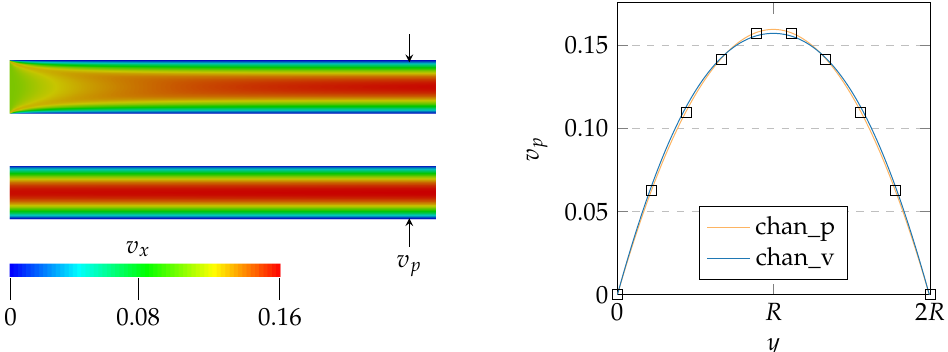
Figure 3. Velocity v x for channel flows with constant inlet velocity v x = 0.1 (picture in the top left ) and constant pressure ρ = 1.016 ( bottom left ) together with velocity profiles v p (plot on the right ). The profiles were taken at points x = 15 × R (marked with arrows), where R is half the channel height. Squares denote reference values computed from Equation (7) for arbitrarily chosen v max =